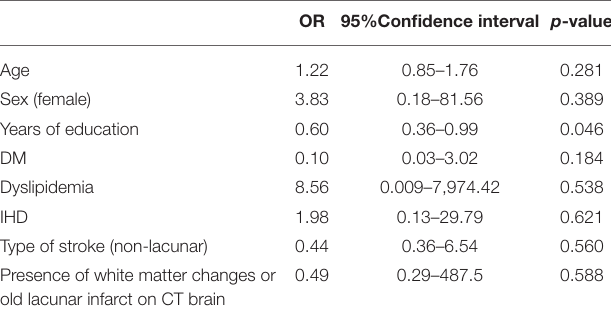
TABLE 4 | Multivariate logistic regression for risk factors of dementia at 6 th month. OR 95%Confidence interval p